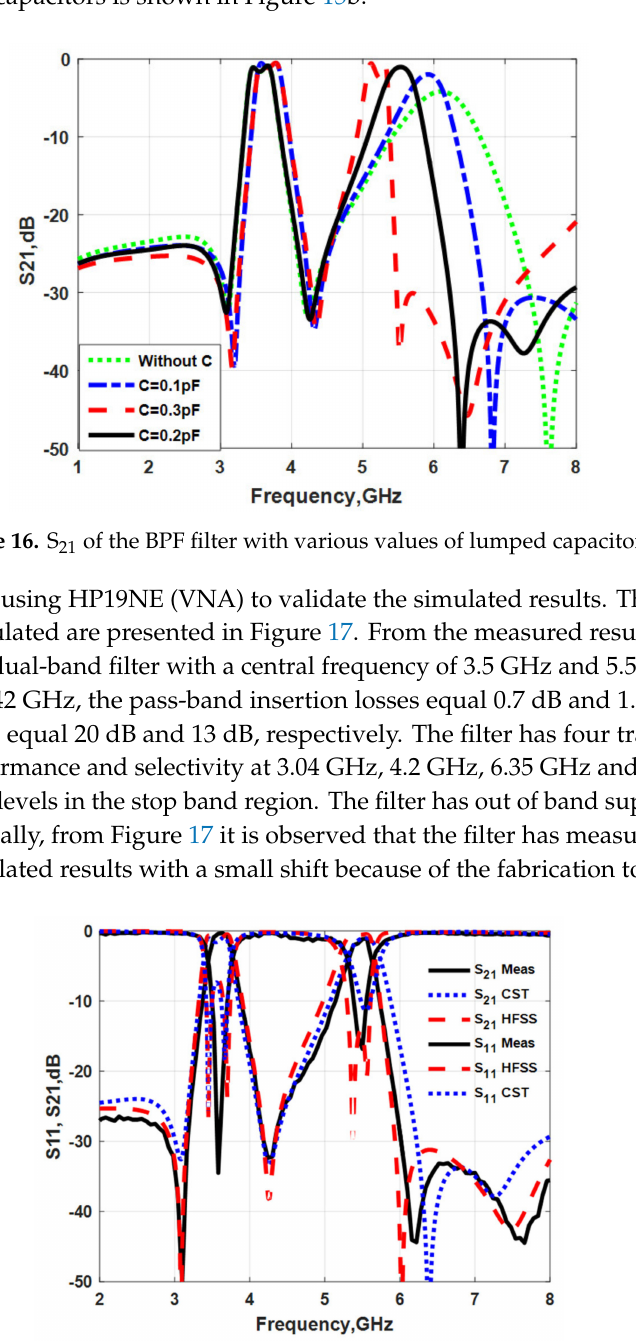
Figure 17. Simulated and measured S 11 and S 21 of the dual-band dual-mode BPF